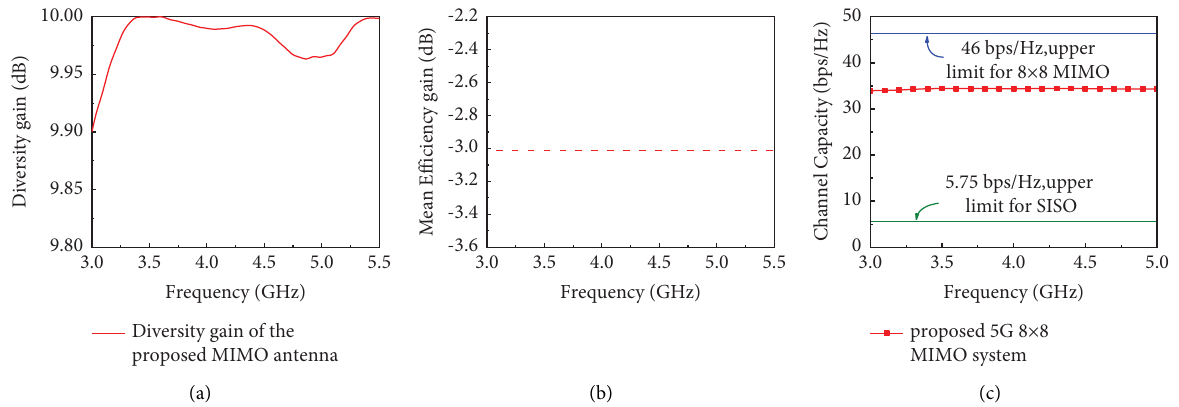
Figure 13: Performance of the proposed antenna system: (a) diversity gain; (b) mean efciency gain; (c) channel capacity.